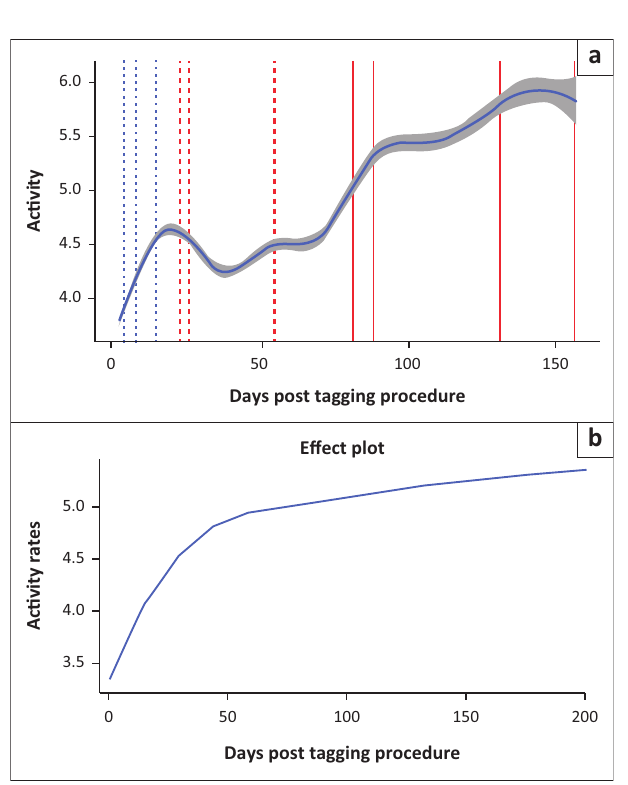
FIGURE 4: The logarithmic activity rates post-tagging of all telemetered Hydrocynus vittatus individuals in the present study where (a) shows the linear regression relationship and (b) the logarithmic regression relationship. In (a), the blue dotted lines represent the recovery periods tested (3 days, 1 week and 2 weeks after tagging), the red dashed lines highlight when the death of a fish was detected, and the solid red lines indicate when the signal was lost.